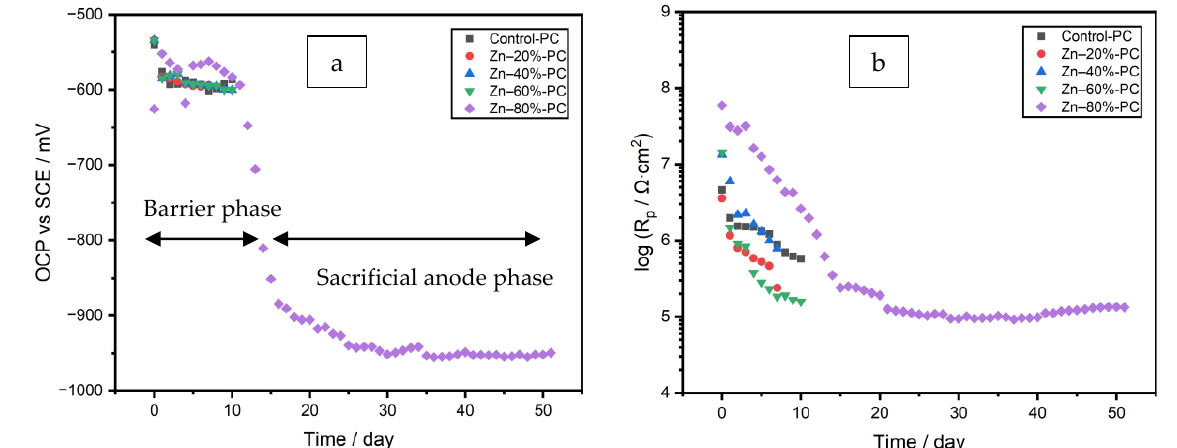
Figure 6. ( a ) OCP and ( b ) R p values of the coatings with zinc (PC).